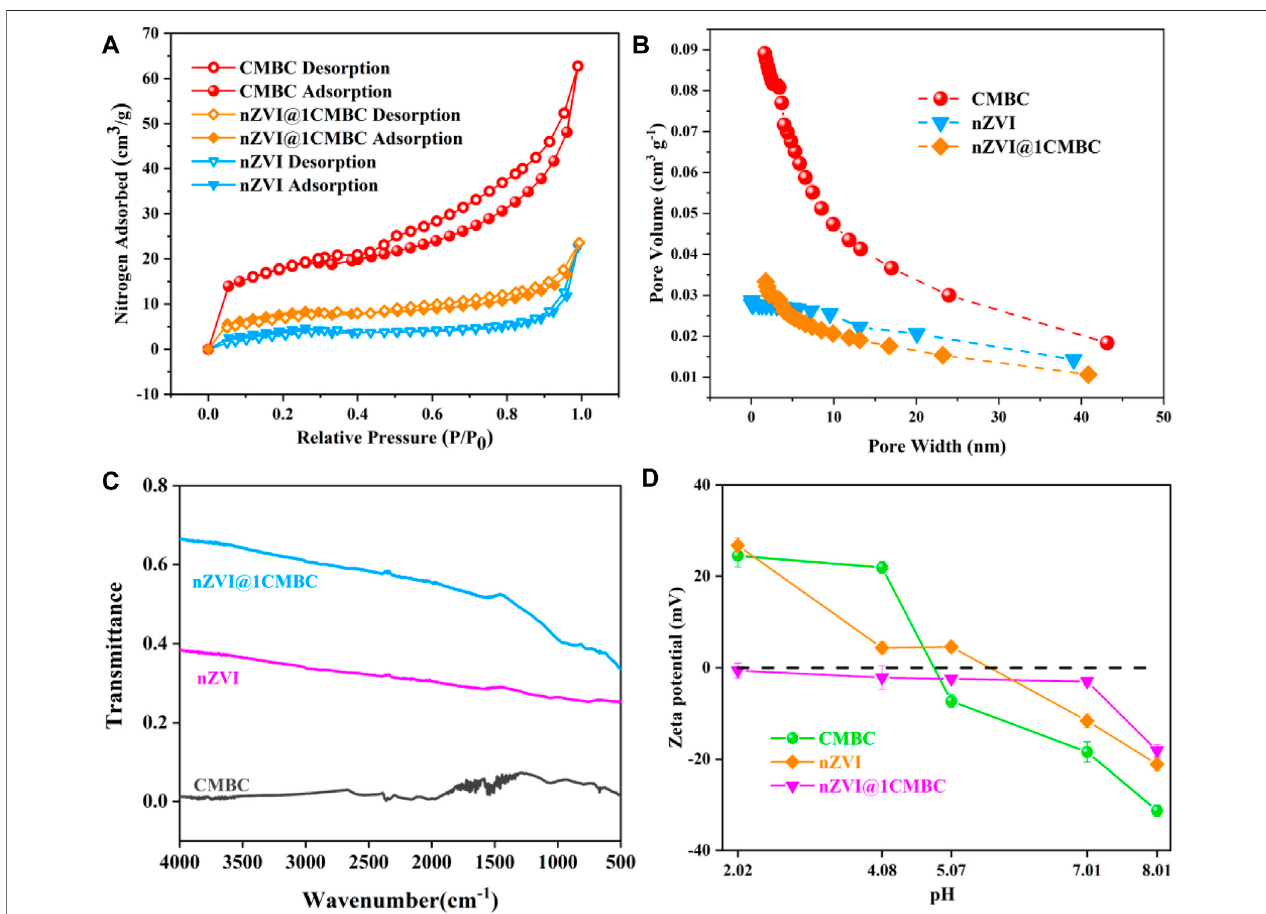
FIGURE 2 | Nitrogen adsorption-desorption isotherm of nZVI, CMBC, and nZVI@1CMBC (A) ; pore size distributions of CMBC, nZVI, and nZVI@1CMBC (B) ; FTIR spectra of samples (C) ; and zeta potentials of nZVI@CMBC at various pH values (D) .